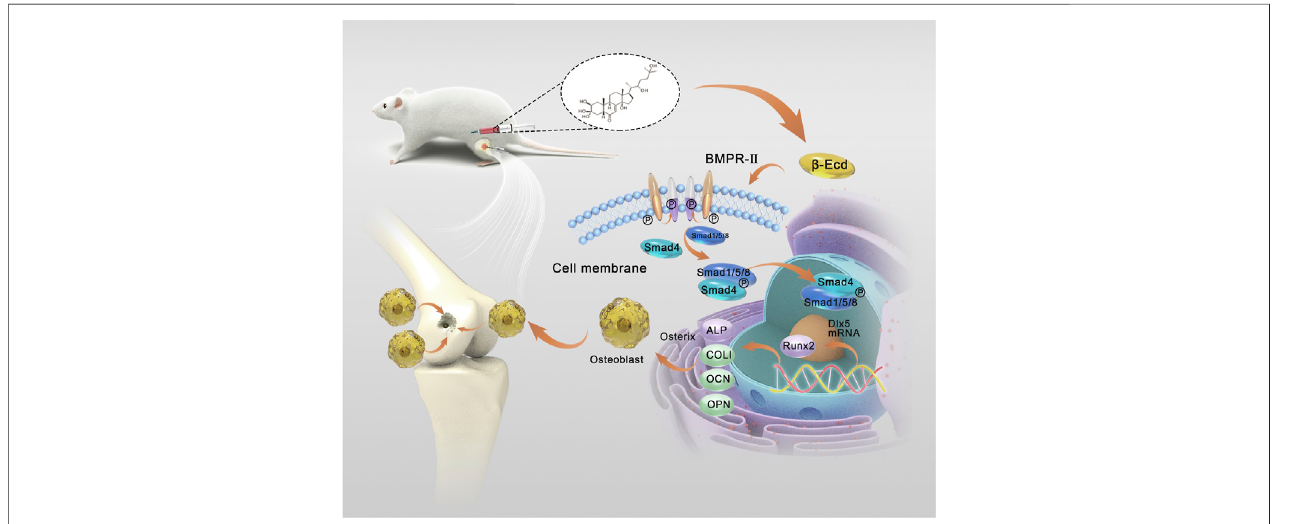
GRAPHICAL ABSTRACT | Schematic illustrations of the fabrication of the bone defect model and action of β -Ecd in promoting bone regeneration and repair of bone defects. We established a rat model of a femoral bone defect in vivo to evaluate the effect of β -Ecd on bone regeneration. Rats injected intraperitoneally with 72 mg/kg β -Ecd showed a higher degree of ossi fi cation of regenerated bone tissue at the site of the bone defect at weeks 4 and 8. β -ecdysterone binding to the BMP2 receptoractivatesSMAD1tobindtoSMAD1/5/8,promotesRUNX2andOSTERIX replicationinthenucleus,andmediatesboneregeneration.Thisstudyprovides a new approach to the treatment of bone injury and degenerative diseases represented by bone defects and osteoporosis.